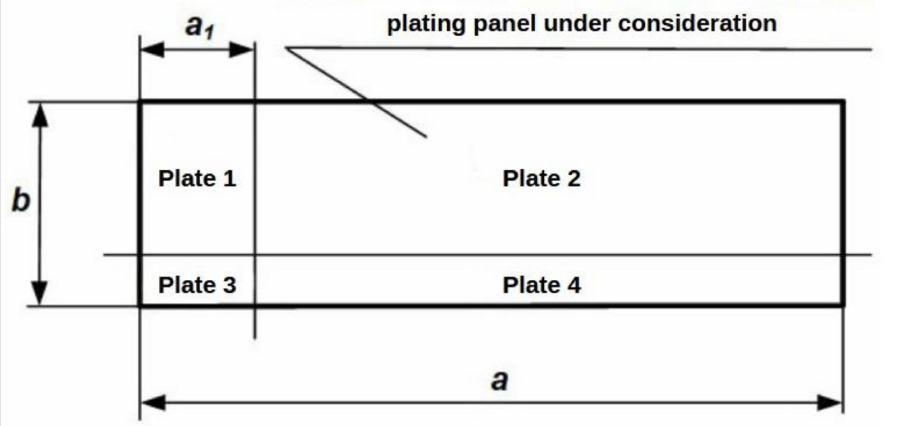
Figure 5. An example of the panel with two intersecting welds.